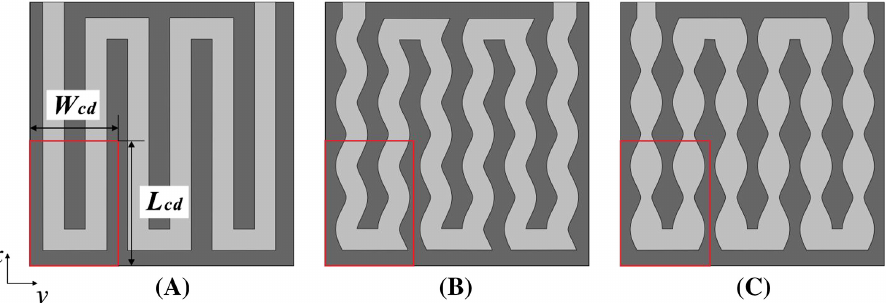
Figure 17. The serpentine flow field with ( A ) straight wall; ( B ) parallel wavy wall; ( C ) symmetrical wavy wall [74].